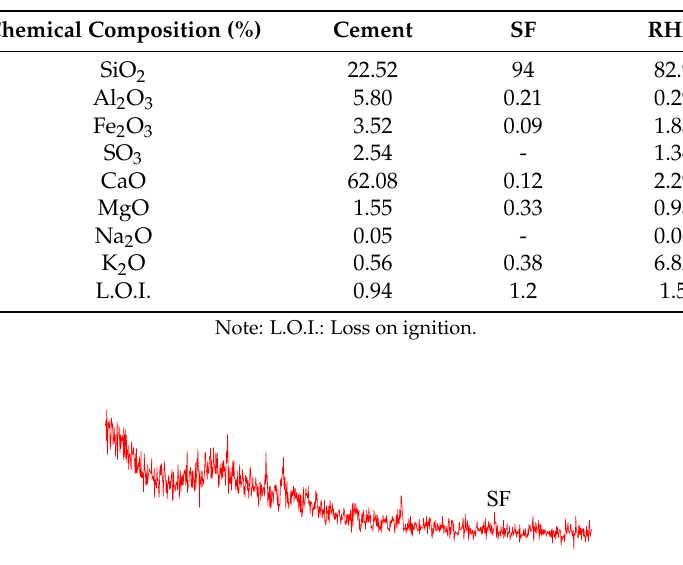
Table 2. Chemical compositions of cement, SF, and RHA.